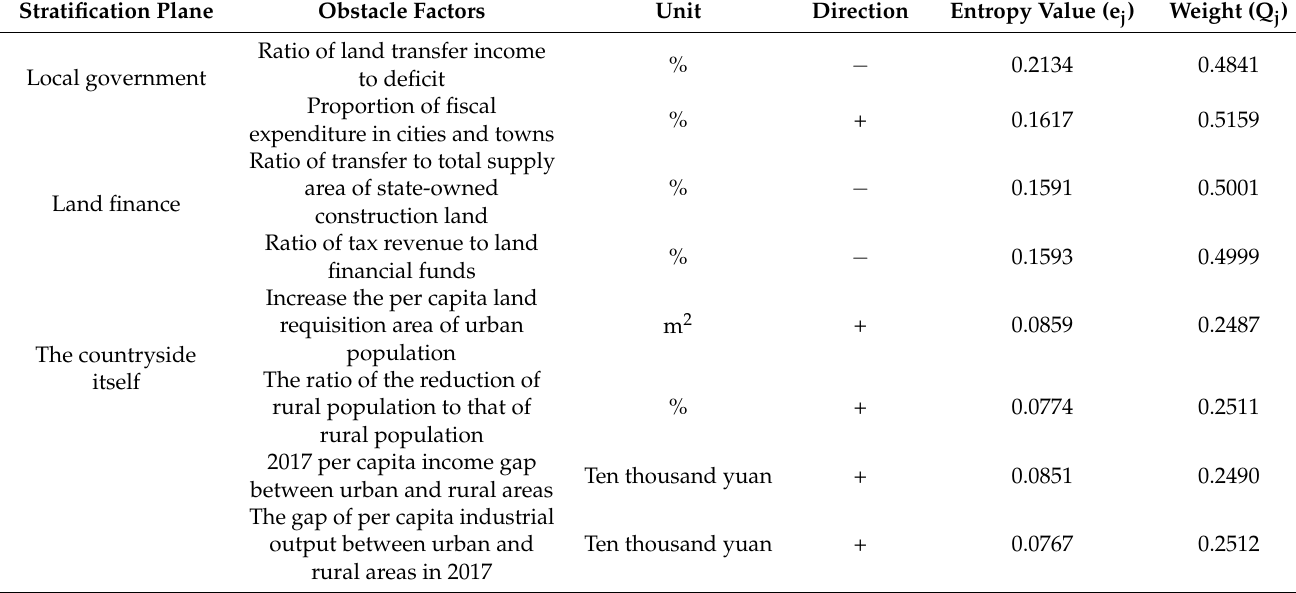
Table 1. Action direction, entropy value, and weight of obstacle